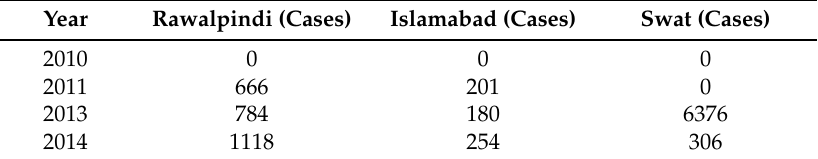
Table 2. Dengue Fever (DF) Cases in the Rawalpindi-Islamabad and Swat [31,32].